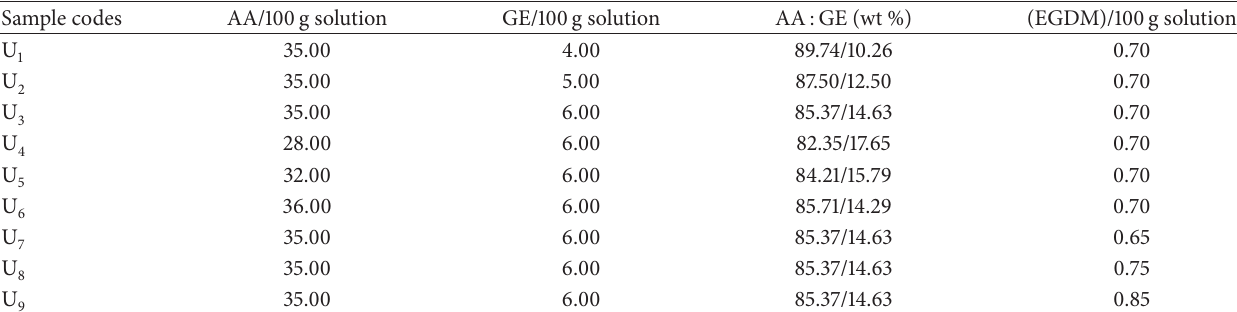
Table 1: Different composition of AA/Gelatin